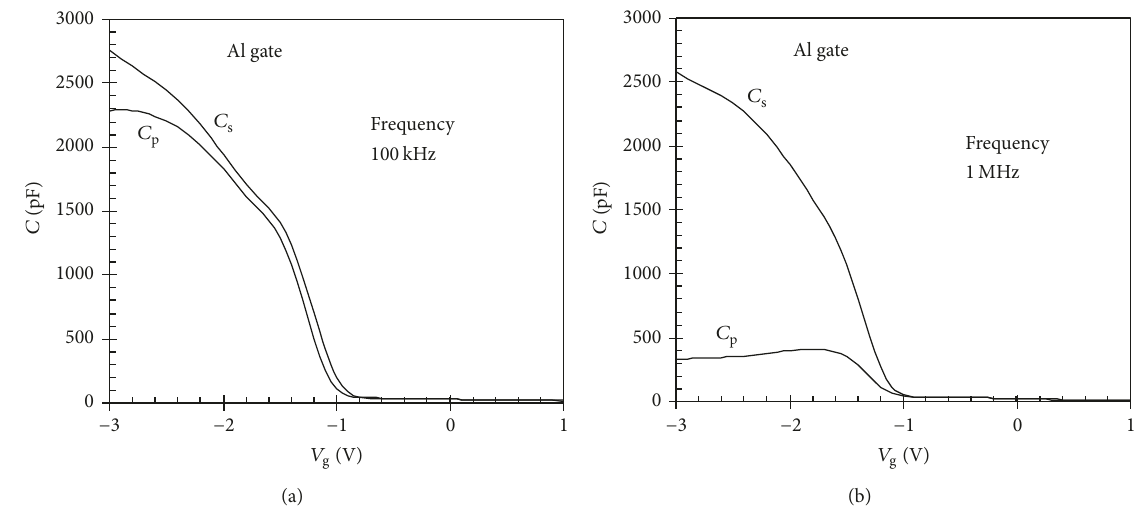
Figure 9: Comparison of 𝐶